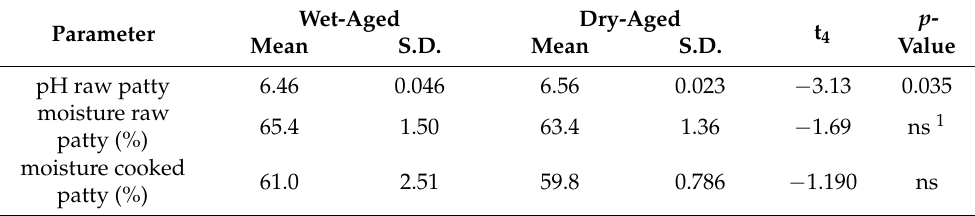
Table 4. Effect of ageing method (dry vs. wet), standard deviation (S.D.), t-value (t) with subscript degrees of freedom and statistical significance ( p -value) on total moisture and pH of mutton patties.